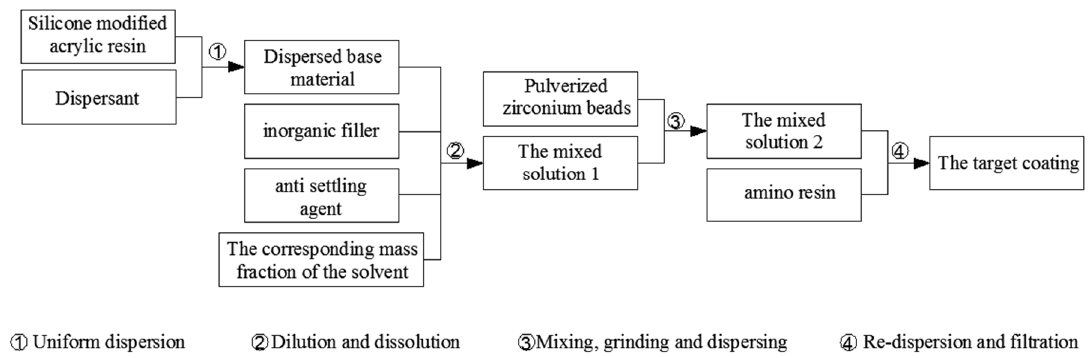
Figure 1. The preparation method of the target coating.